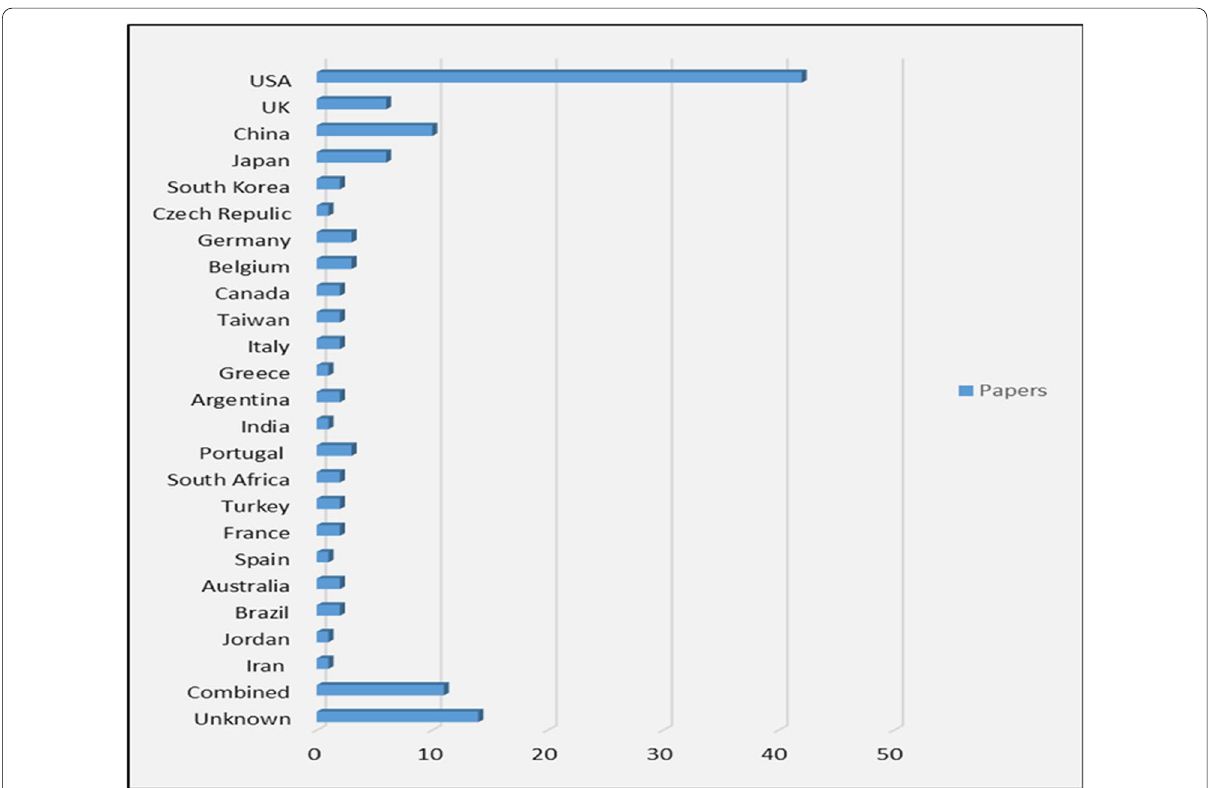
Fig. 3 Distribution of papers found for individual